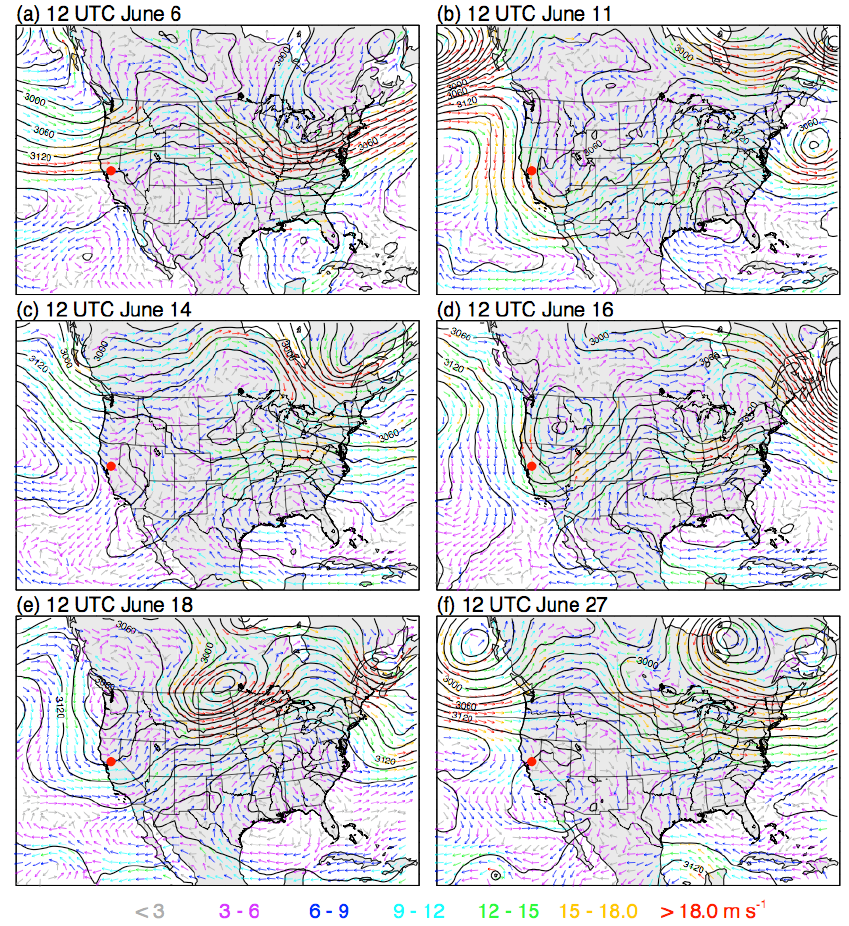
Figure 3. Winds (arrows) and geopotential heights (contours) at 700 hPa from the NAM analyses at 12 964 Fig. 3. Winds (arrows) and geopotential heights (contours) at 700hPa from the NAM analyses at 12:00UTC on (a) 6 June, (b) 11 June, (c) UTC on (a) June 6, (b) June 11, (c) June 14, (d) June 16, (e) June 18, and (f) June 27. Red dot denotes 965 14 June, (d) 16 June, (e) 18 June, and (f) 27 June. Red dot denotes Sacramento. Contour interval of Sacramento. Contour interval of 30 m. 966